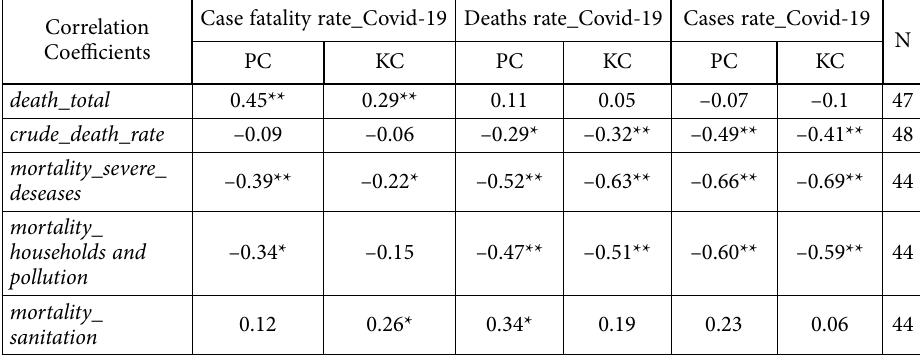
Table 3. Correlation analysis between mortality indicators and Covid-19 indicators (source: authors’ computation using IBM SPSS Statistics 21) Correlation